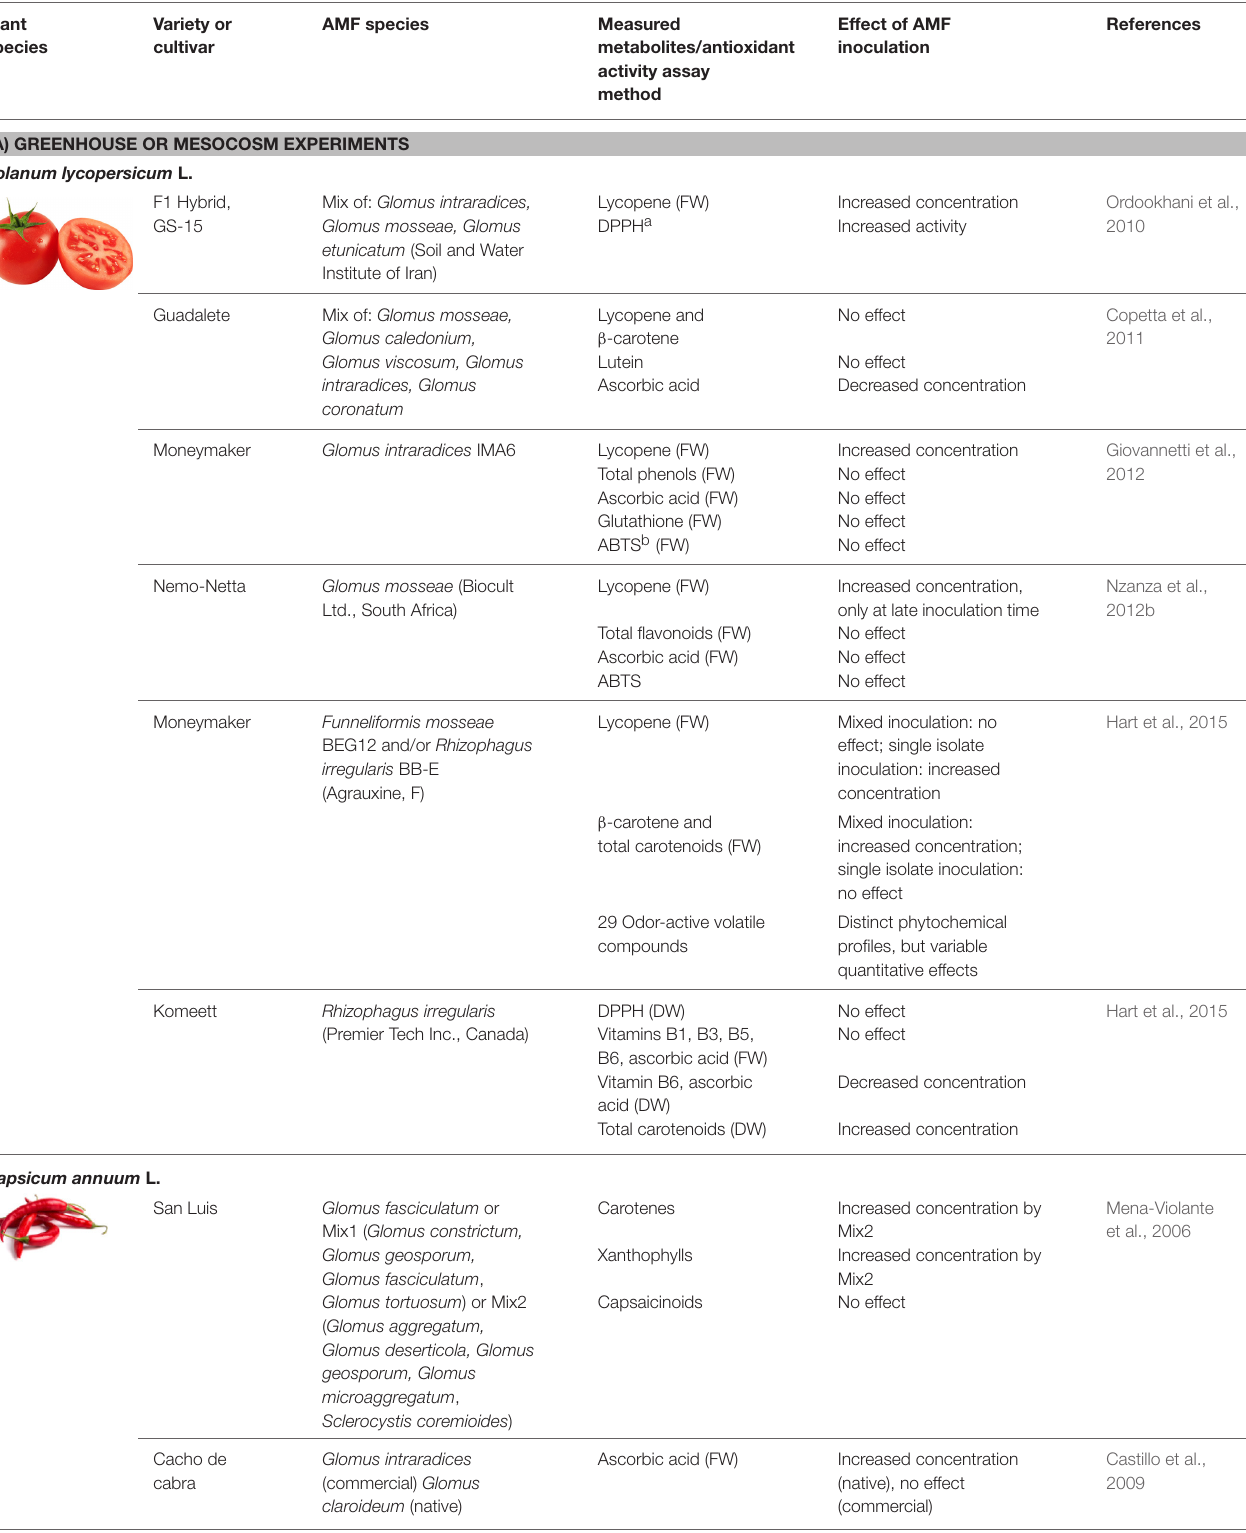
TABLE 1 | Secondary metabolites and antioxidant activities in mycorrhizal food plants. Plant